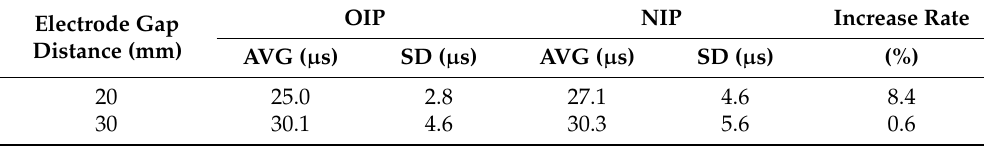
Table 2. Chop time of OIP and NIP under negative lightning impulse voltages.